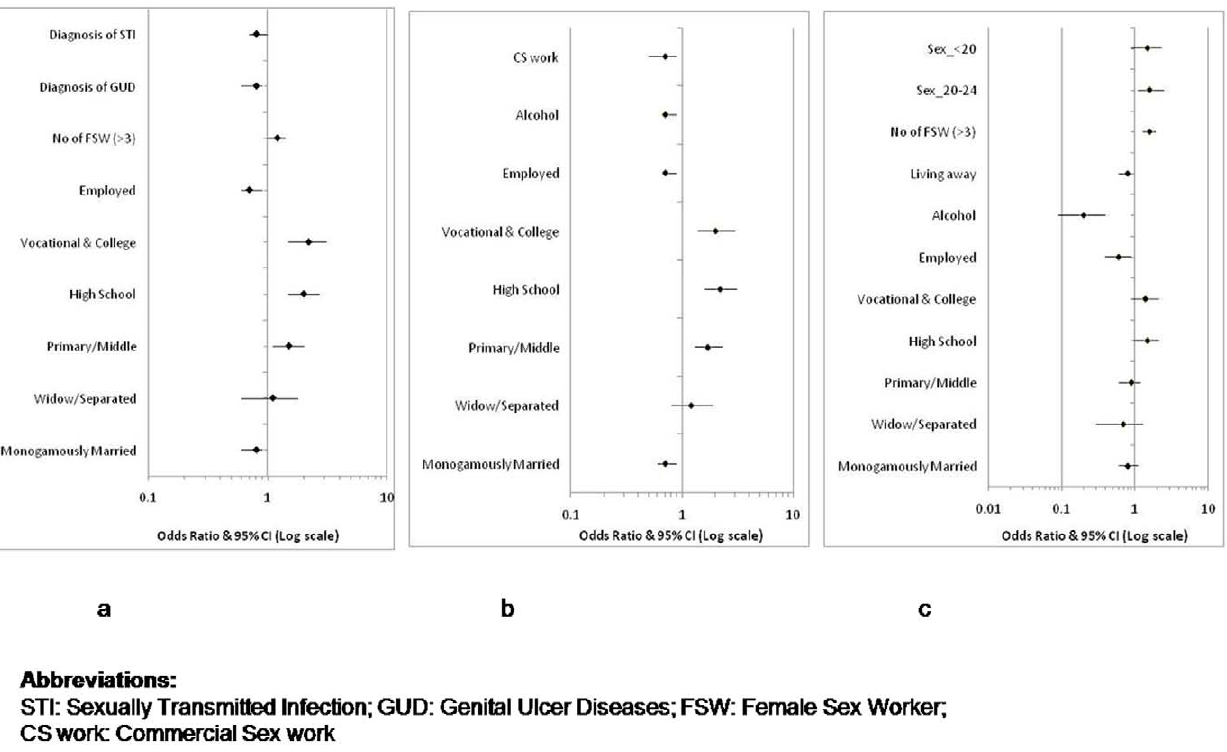
Figure 1. Predictors of retention in the modeled scenario of primary prevention (1a), cohort study (1b) and clinical trial (1c).